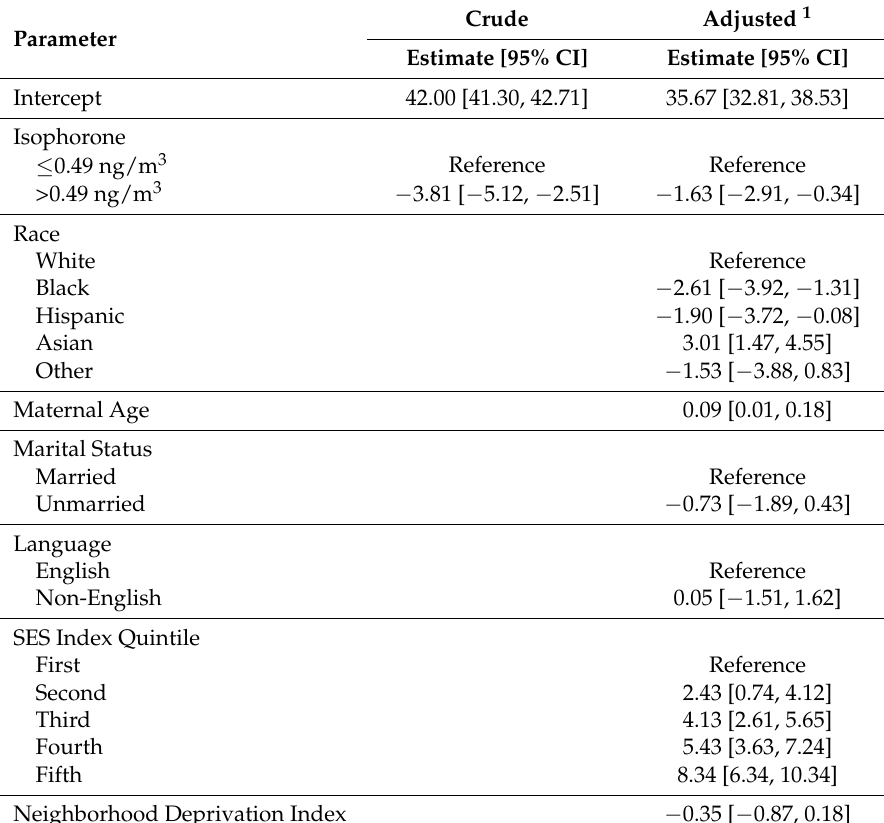
Table 2. Crude and adjusted 1 parameter estimates for associations between high isophorone exposure and math scale scores among the subset of the ECLS-B 2001 birth cohort living in urban communities (N = 4050).